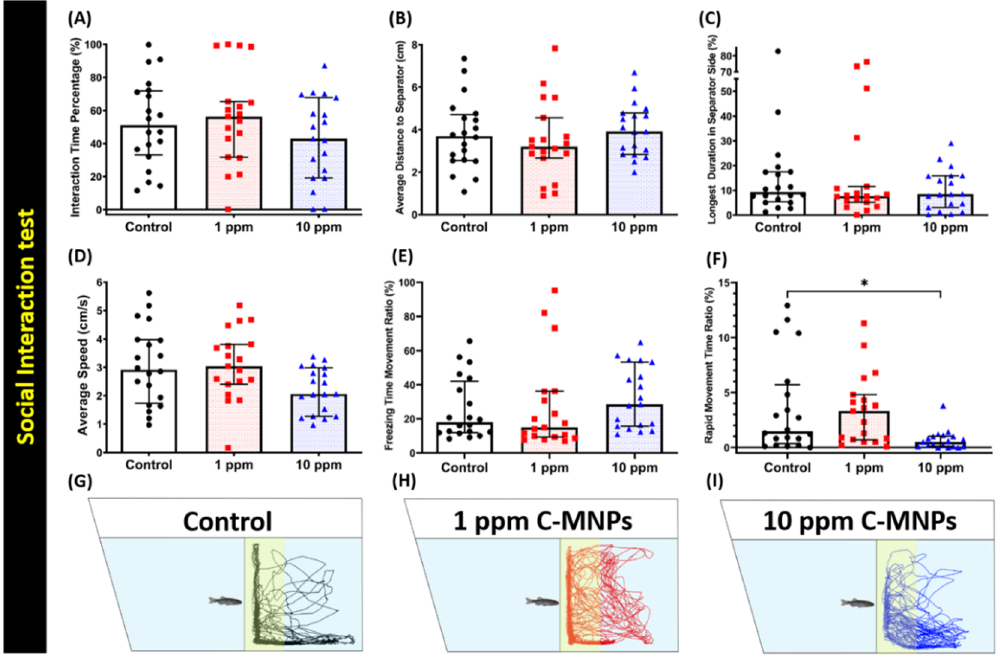
Figure 6. Endpoint comparisons between the control group, 1 ppm, and 10 ppm C-MNPs-exposed zebrafish groups after two weeks of exposure. ( A ) Interaction time percentage, ( B ) average distance to the separator, ( C ) longest duration in the separator side, ( D ) average speed, ( E ) freezing time movement ratio, and ( F ) rapid movement time ratio were analyzed. ( G – I ) The 5 min locomotor trajectories for the control, 1 ppm, and 10 ppm C-MNPs-exposed fish in the conspecific social interaction test. The data are expressed as the median with an interquartile range and were analyzed by the Kruskal-Wallis test, which continued with Dunn’s multiple comparisons test as a follow-up test ( n = 20, * p < 0.05).